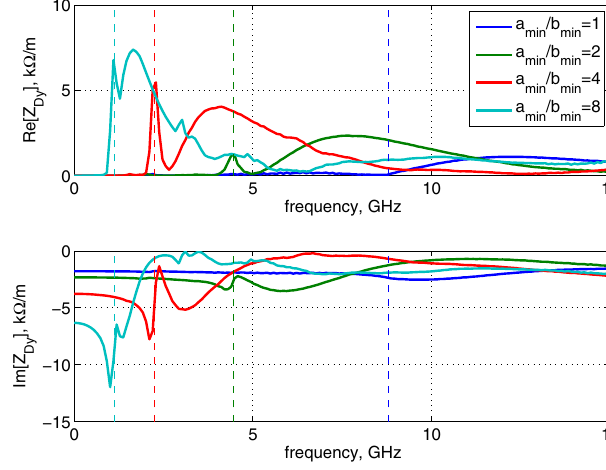
FIG. 5. (Color) Dipolar-horizontal impedance (solid line) and cutoff frequencies of the structure (dashed line). H S 11